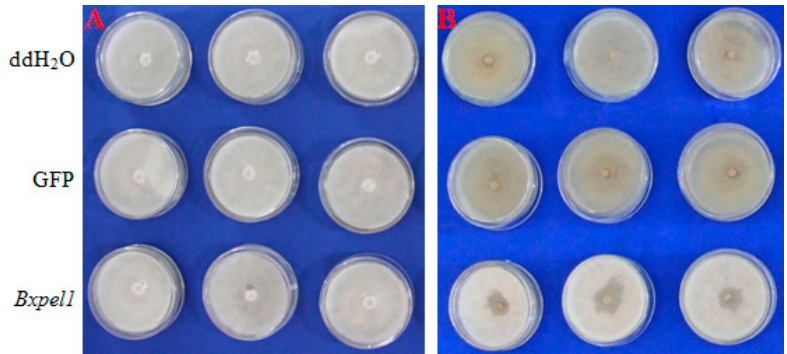
Figure 4. Effects of GFP gene dsRNA on propagation of B. xylophilus . ( A ) B. xylophilus inoculating on B. cinerea on the first day; ( B ) B. xylophilus inoculating on B. cinerea on the seventh day .